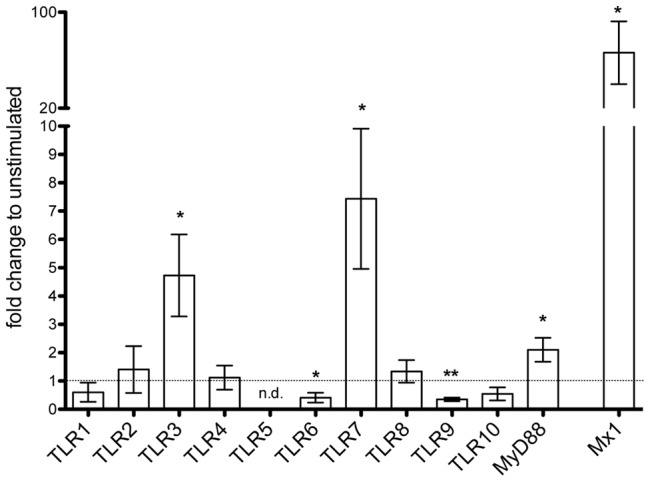
Differential regulation of TLR mRNA expression in human PBMCs by interferon-β.PBMCs from healthy donors were incubated with 1000 U/ml interferon-β. Untreated cells served as control. After 6 hours of treatment RNA was isolated and qRT-PCR performed with primers for TLR1-10, MyD88, and MX1. Results (mean±SD) from n = 3 independent experiments with PBMCs from different healthy donors are shown as fold-change to unstimulated controls. The dotted line marks the expression level in unstimulated control PBMCs, which was set to 1. Statistical significance of differences was assessed by paired t-test. *p<0.05; **p<0.01; n.d., not detectable.